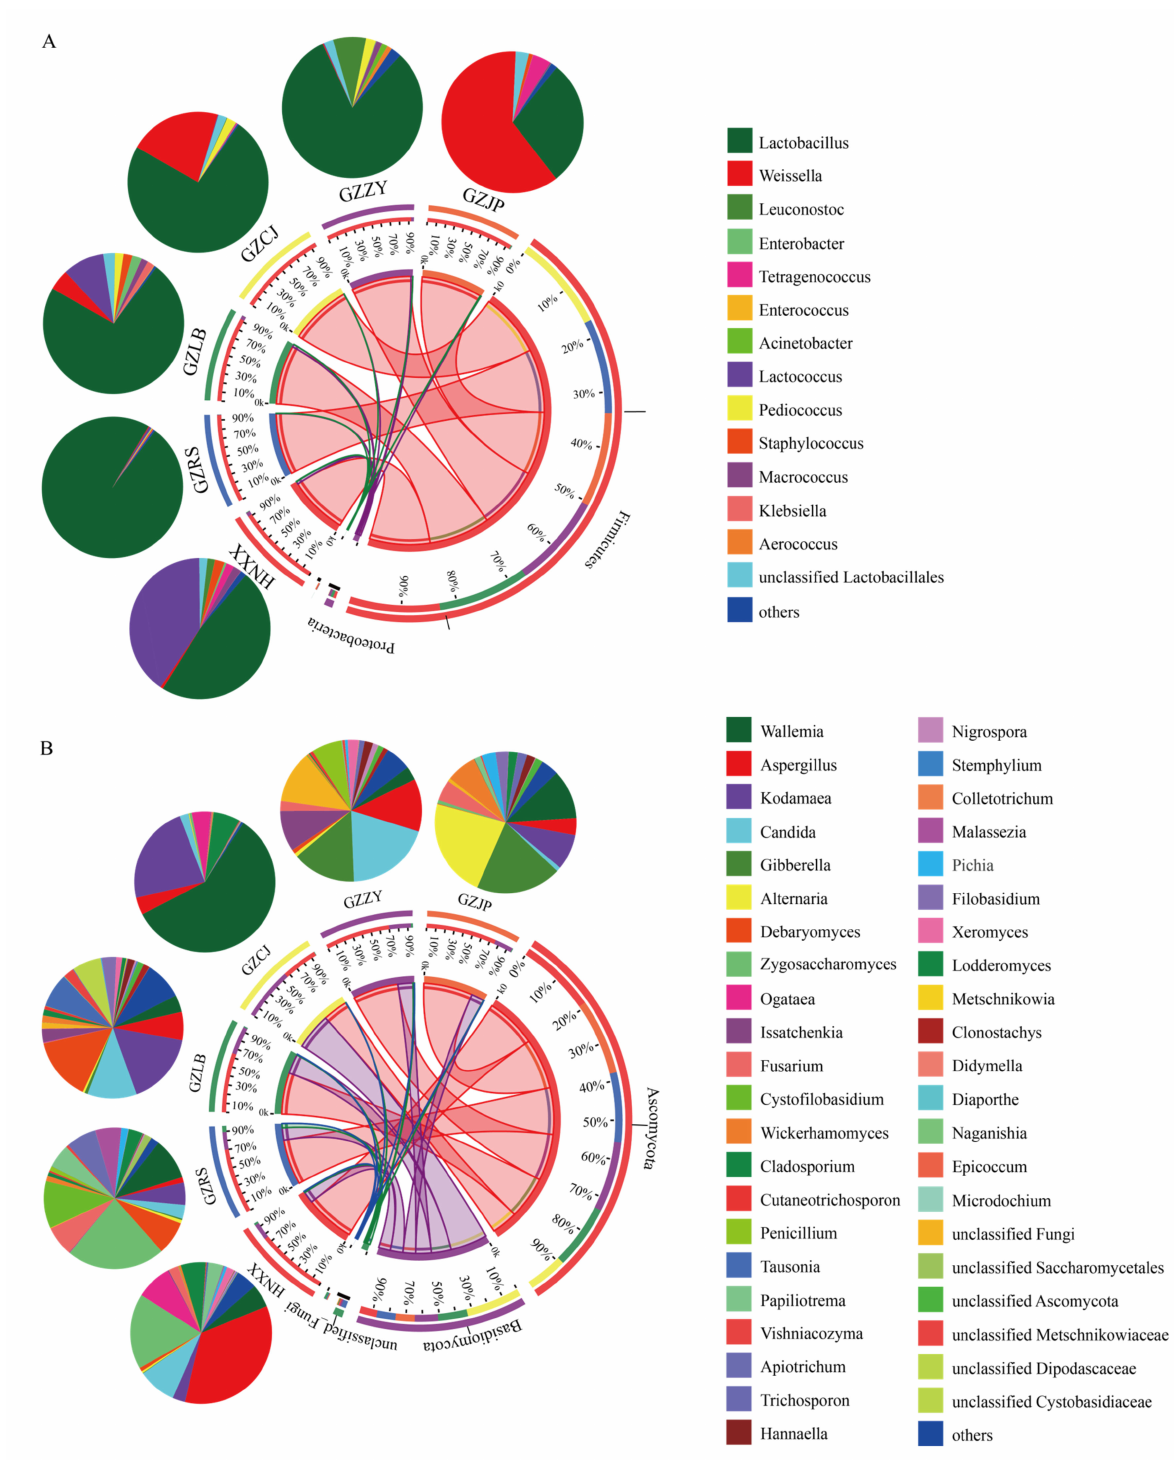
Figure 2. Relative abundance of bacteria at the phylum and genus level ( A ) and fungi at the phylum and genus level ( B ) of SR from different